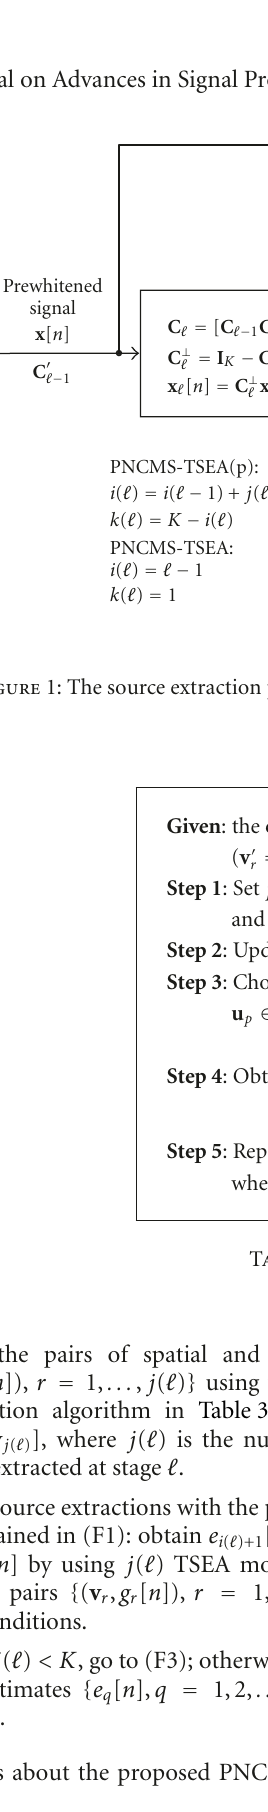
classification algorithm in Table 3 and set C (cid:10) [ v 1 , ... , v j ( (cid:5) ) ], where j ( (cid:5) ) is the number of distinct sources extracted at stage (cid:5)